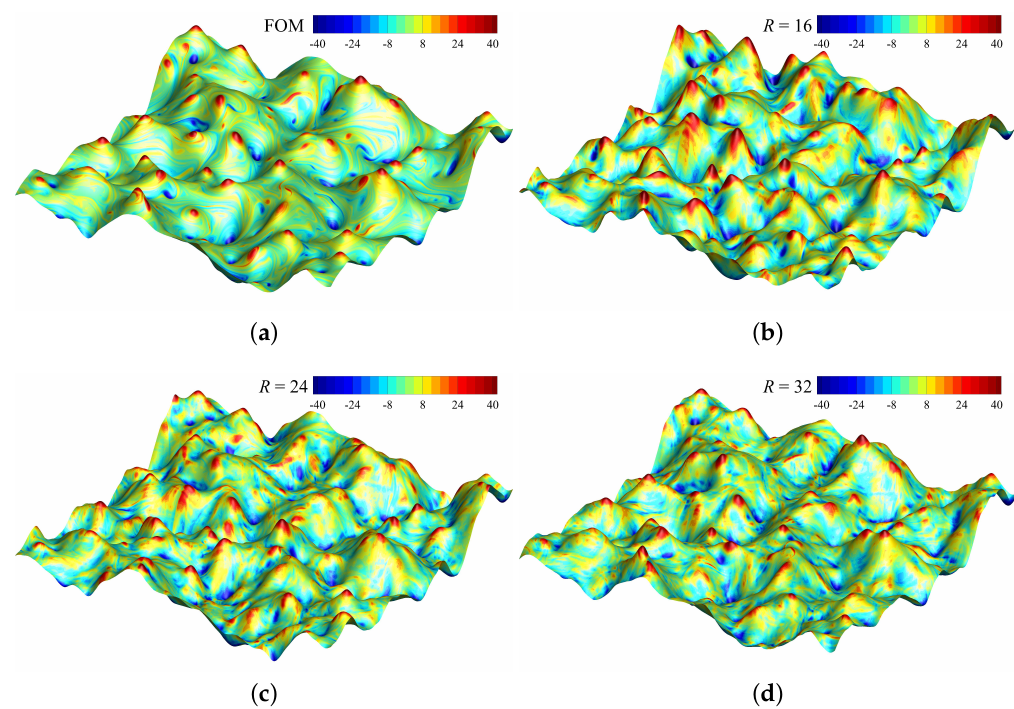
Figure 5. Predicted results at time t = 4 showing vorticity contours in color with the level of streamfunction as height. ( a ) Full order model (FOM), ( b ) ROM ( R = 16) with P = 1, ( c ) ROM ( R = 24) with P = 1, and ( d ) ROM ( R = 32) with P = 1. Note that P = 1 refers to the standard Galerkin ROM approach using a single partitioning zone.